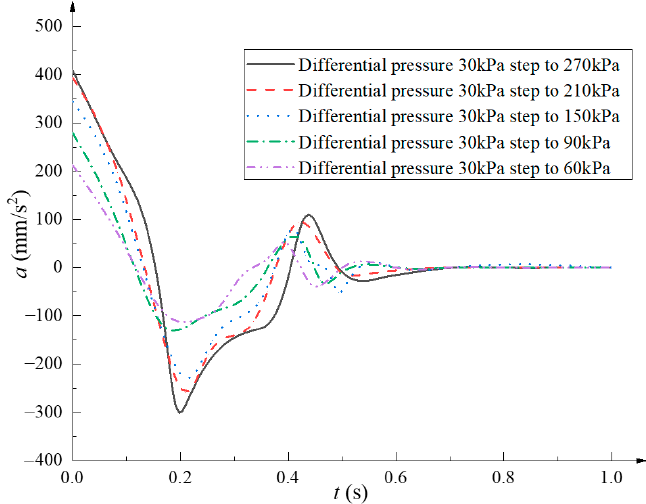
Figure 7. Valve core acceleration dynamic characteristic curve.